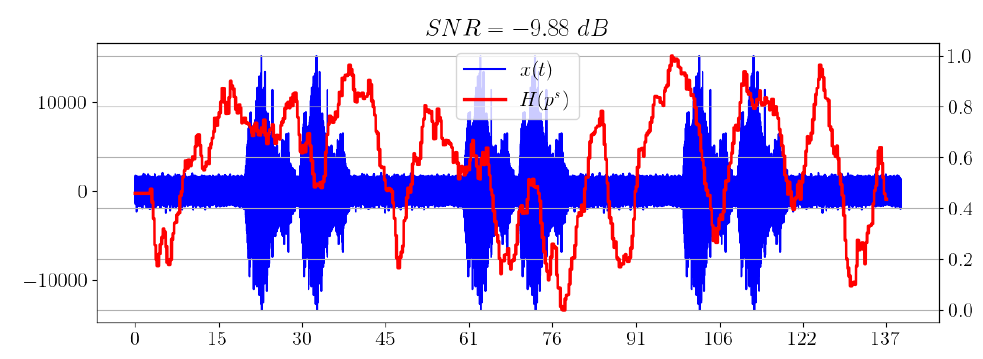
Figure 10. Spectral entropy for pink noise model.